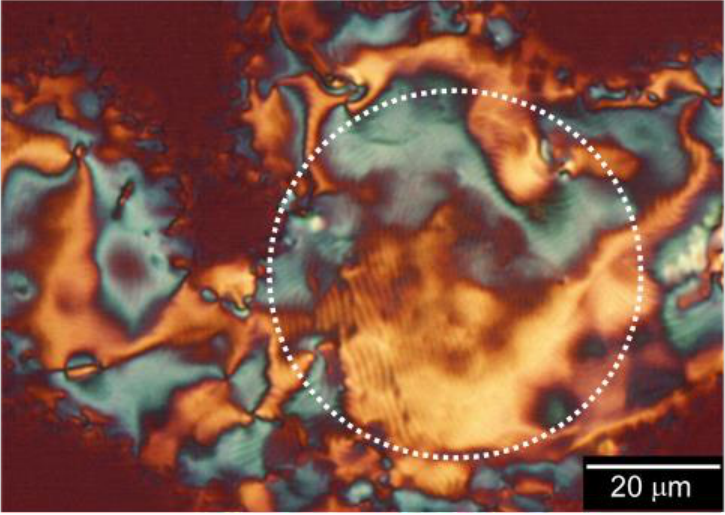
Figure 4. POM image of poly(Ac–Pyr) with the insertion of a gypsum first-order red plate under cross-Nicol conditions. Inside the dotted circle shows the fingerprint–textured stripe.